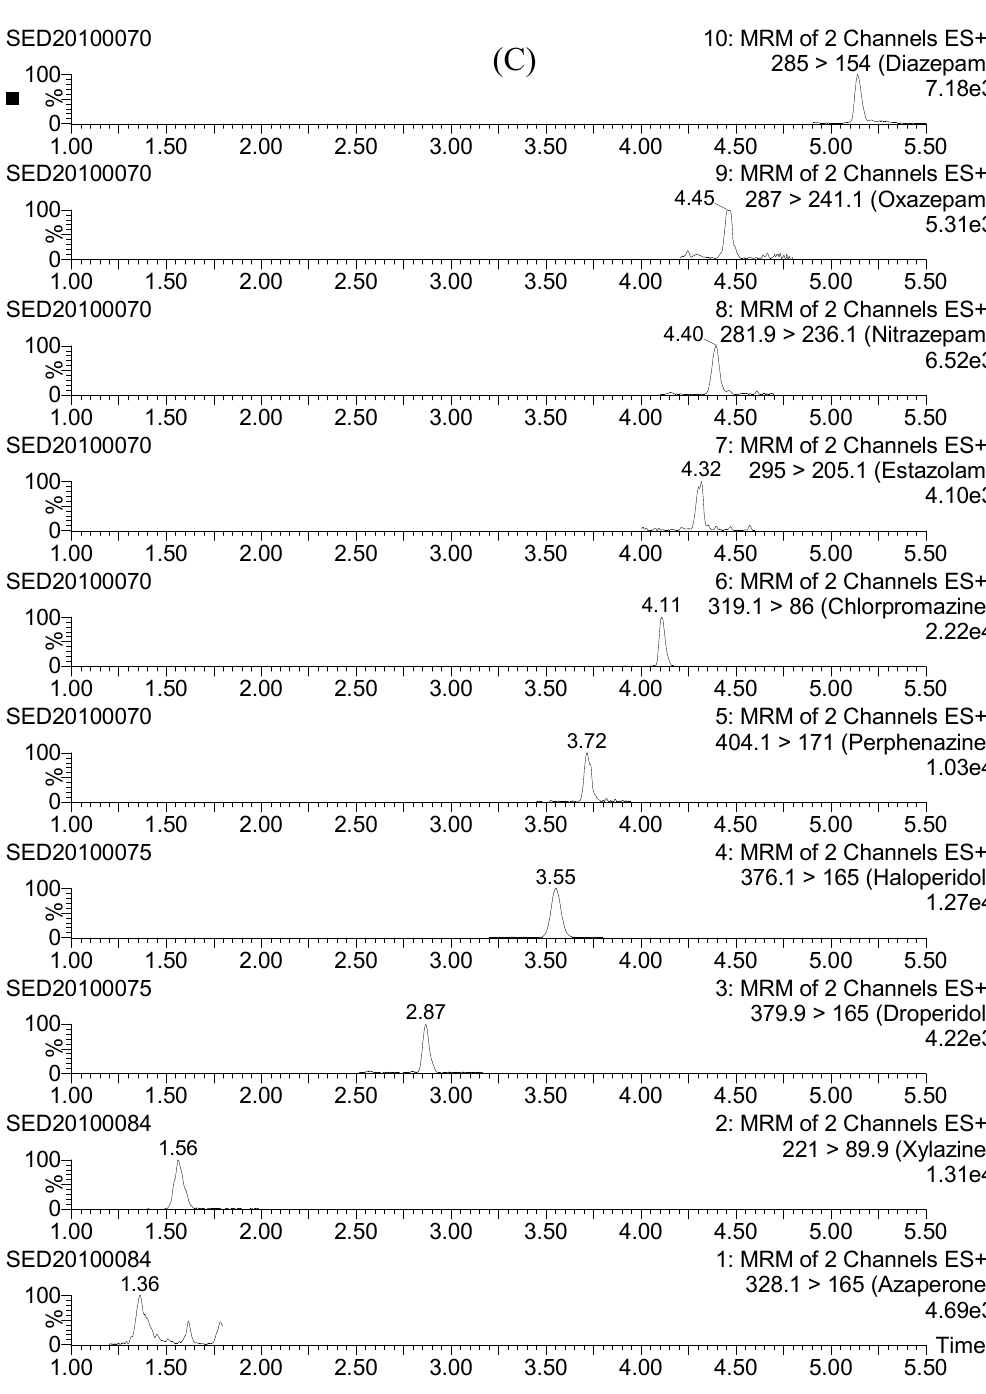
Figure 4. Typical ultra-high-performance liquid chromatography tandem mass spectrometry (UHPLC-MS/MS) chromatograms of blank sample (A), fortified sample (B), and matrix-matched standard (C).